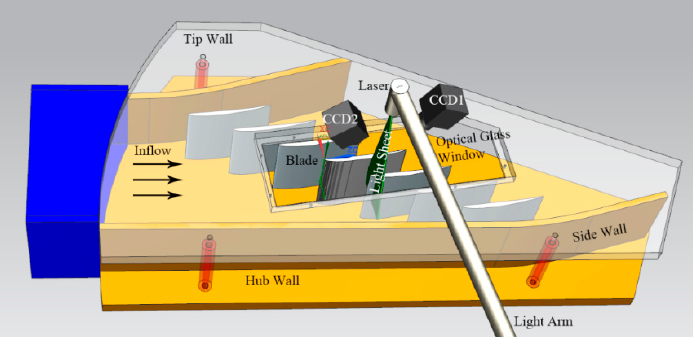
Figure 1. Schematic of the low-speed cascade wind tunnel.